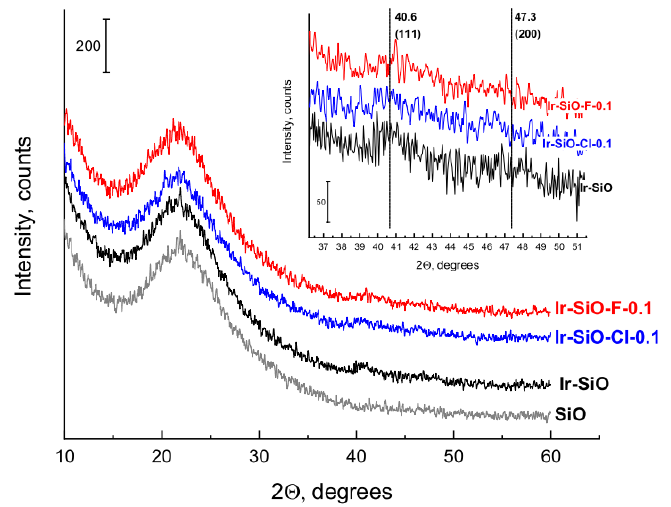
Figure 7. X-ray diffraction patterns of unmodified silica and iridium catalysts reduced at 400 °C. The XRD patterns of iridium catalysts show weak reflections at 2 Θ = 40.6° (111) and 47.3° (200) corresponding to metallic iridium with a fcc structure [34]. The intensity of the reflections is very small, although noticeable, which for such a low loading of the support surface may indicate a crystallite size of about 5 nm. Particularly visible is the reflex at 2 Θ = 40.6° for Ir-SiO catalyst. It indicates that the modification of the silica support leads to a better dispersion of active phase for Ir-SiO-Cl-0.1 and Ir-SiO-F-0.1 catalysts. The XRD re- sults were confirmed by hydrogen chemisorption measurements.